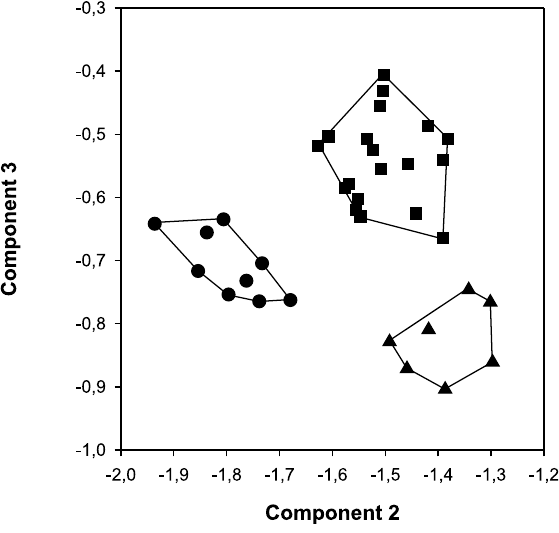
Fig. 7. Principal components analysis on covariance matrix of log-transformed measurements of Hemiancistrus votouro (triangles), H . meizospilos (squares) and H . chlorostictus (circles). Scatter plot of scores on second (PC2) and third principal components